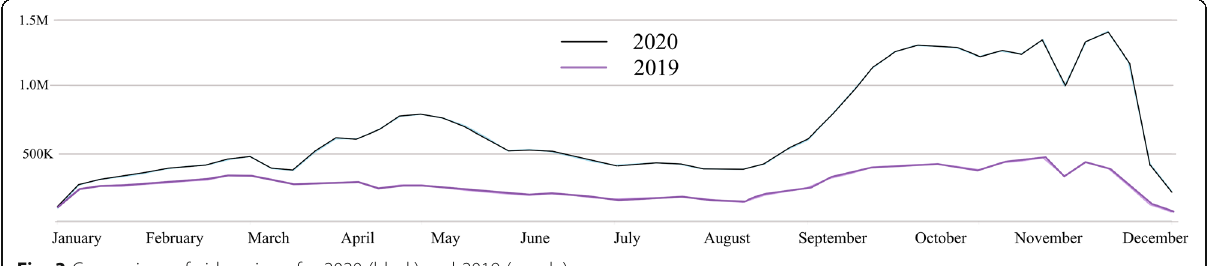
Fig. 3 Comparison of video views for 2020 (black) and 2019